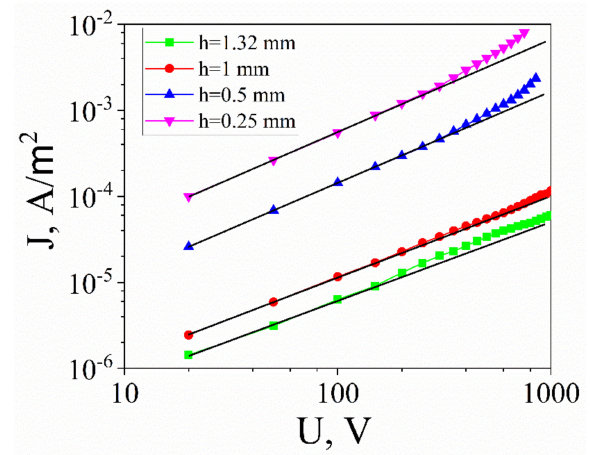
Figure 4. Current density of the platelet capacitors of BTO + 10Mn ceramics. The evaluation of the bulk and contact resistance was done based on linear fit ( black solid lines ).